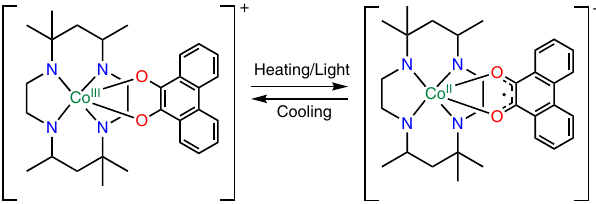
Fig. 1 VT in 1·0.5EtOH. Schematic representation of the electron transfer behavior of the complex motif.